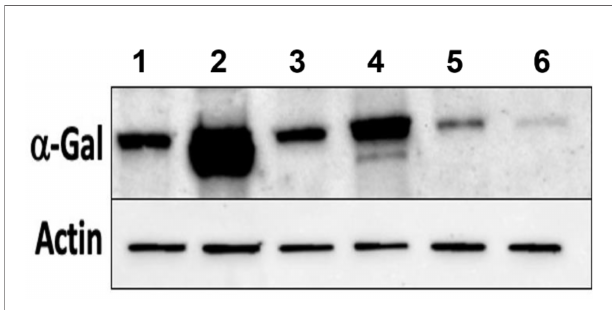
FIGURE 3 | Western blot analysis of a -gal using anti-gal IgM in dsADGal ( a -galactosidase) and dsGFP(irrelevant control)-injected partially fed Am. americanum salivary glands (pooled SG; N=5 ticks). Lane 1, 5 days post infestation (dpi.) dsADGal salivary glands; Lane 2, 5 dpi dsGFP salivary glands; Lane 3, 7 dpi dsADGal salivary glands; Lane 4, 7 dpi dsGFP salivary glands; Lane 5, 9 dpi dsADGal salivary glands; Lane 6, 9 dpi dsGFP